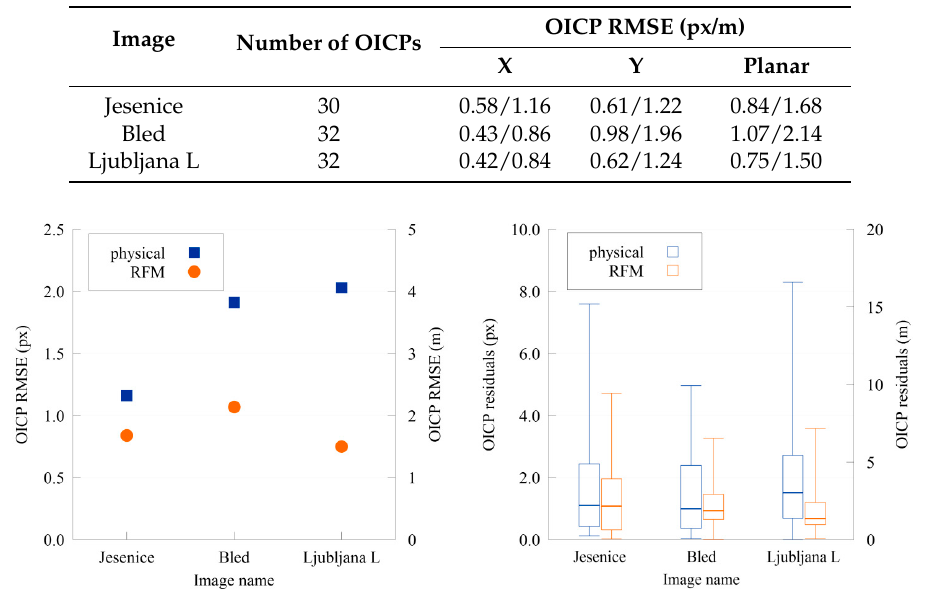
Figure 14. Left : Comparison of the OICP RMSE in pixels/meters for the orthoimages obtained with the physical sensor model (squares) and RFM (circles) for three multispectral WorldView-2 1B images when compared to the reference aerial orthophoto (see Tables 6 and 8). Right : Boxplots of corresponding OICP residuals.